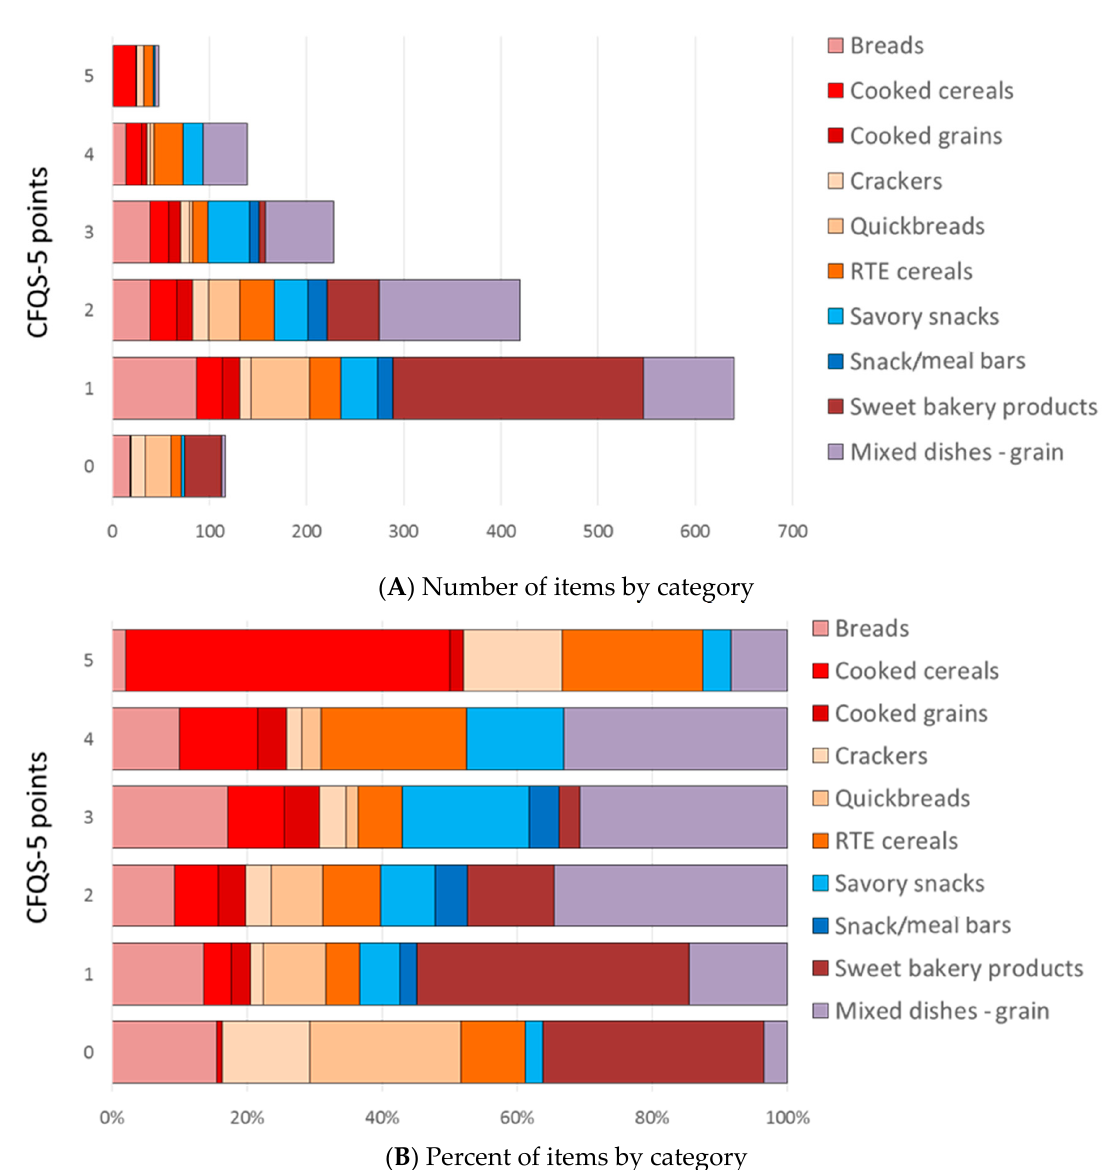
Figure 4. Distribution of CFQS-5 scores for the grain group ( N = 1561) shown as point values ( A ) the relative percent contribution from each food category to each point